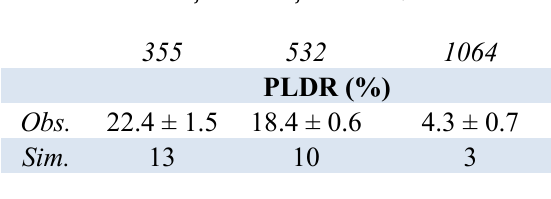
Table 2 . Leipzig measurements vs superposition T – matrix simulations for a fractal aggregate